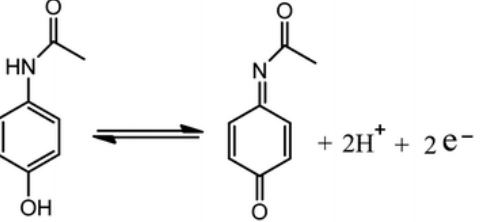
Figure 1. Schematic of the oxidation of paracetamol